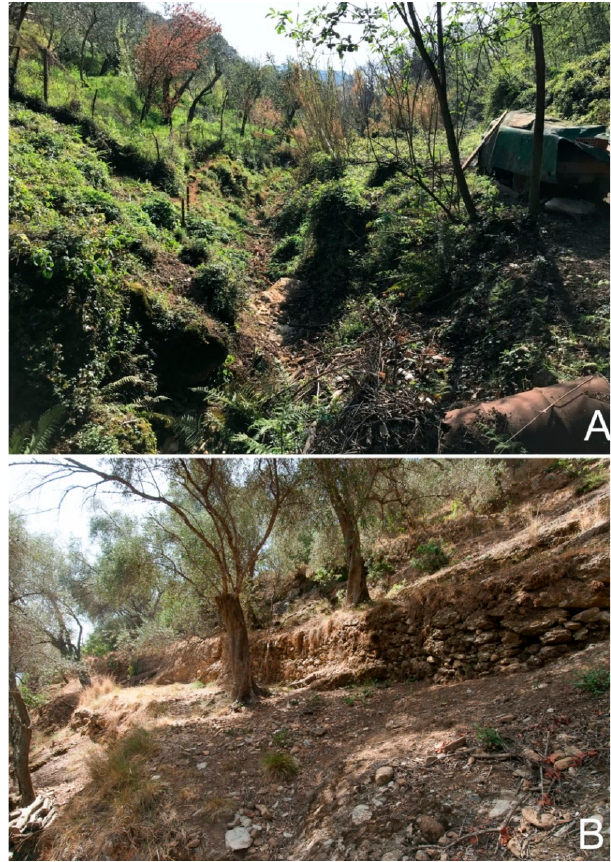
Figure 4. Terraces in the case study area: ( A ) not maintained in Paraggi catchment (n. 8 in Figure 1) close to the stream, and ( B ) partially maintained in San Fruttuoso (Figure 1, catchment n. 3). Remote Sens. 2022 , 14 , x FOR PEER REVIEW